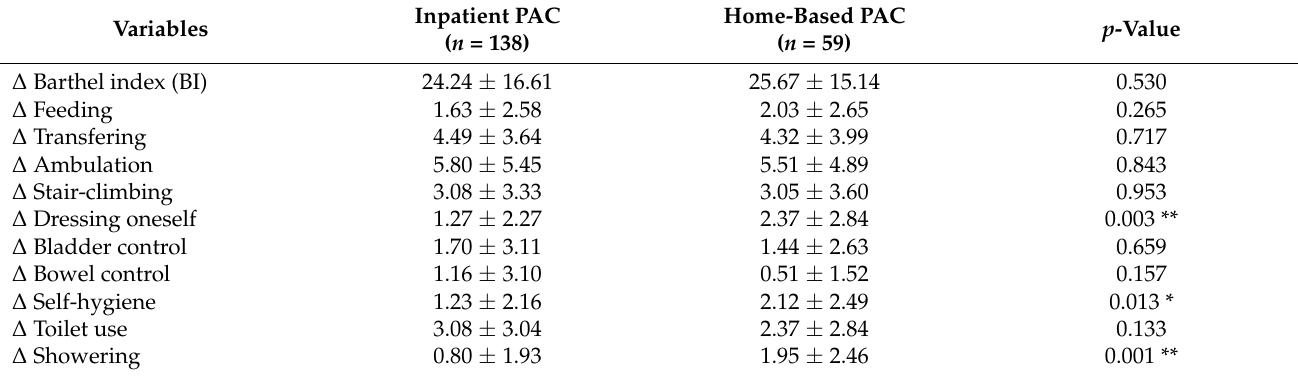
Table 2. Functional improvements in the Barthel index score of the inpatient and home-based PAC groups.